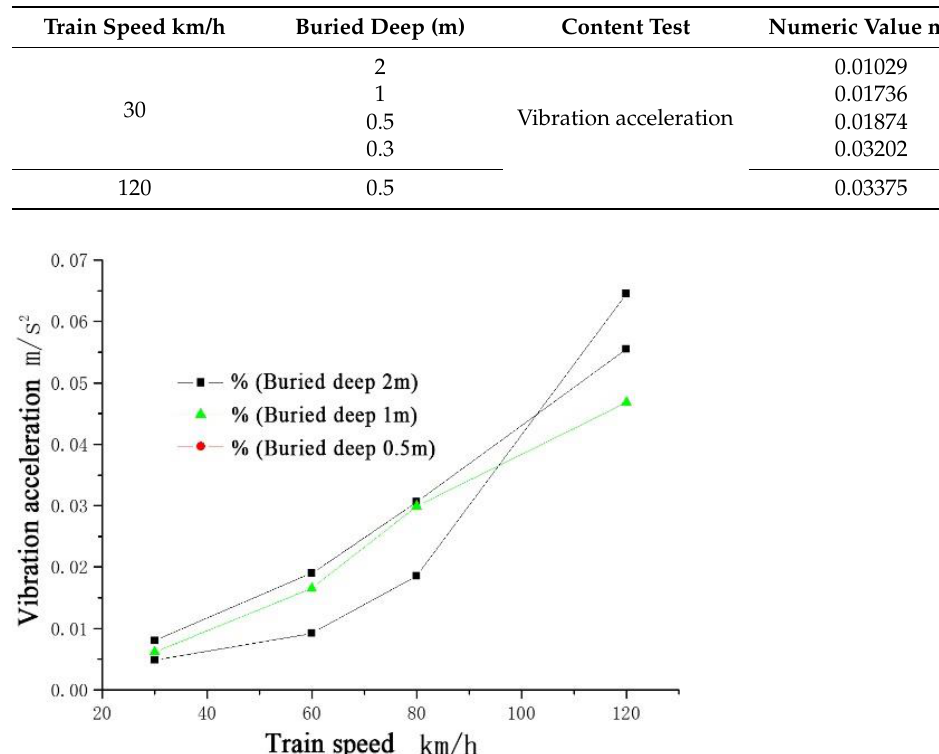
Table 2. Vibration acceleration distribution.